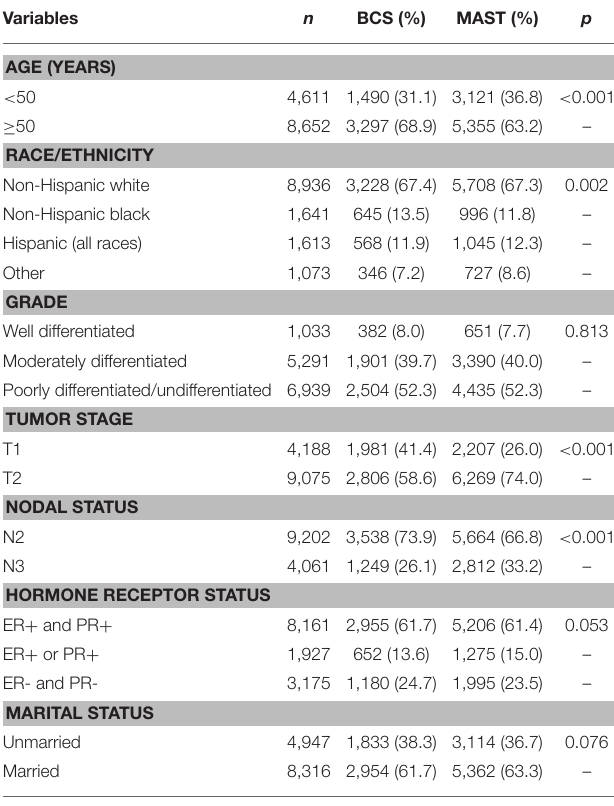
TABLE 1 | Patient characteristics according to treatment